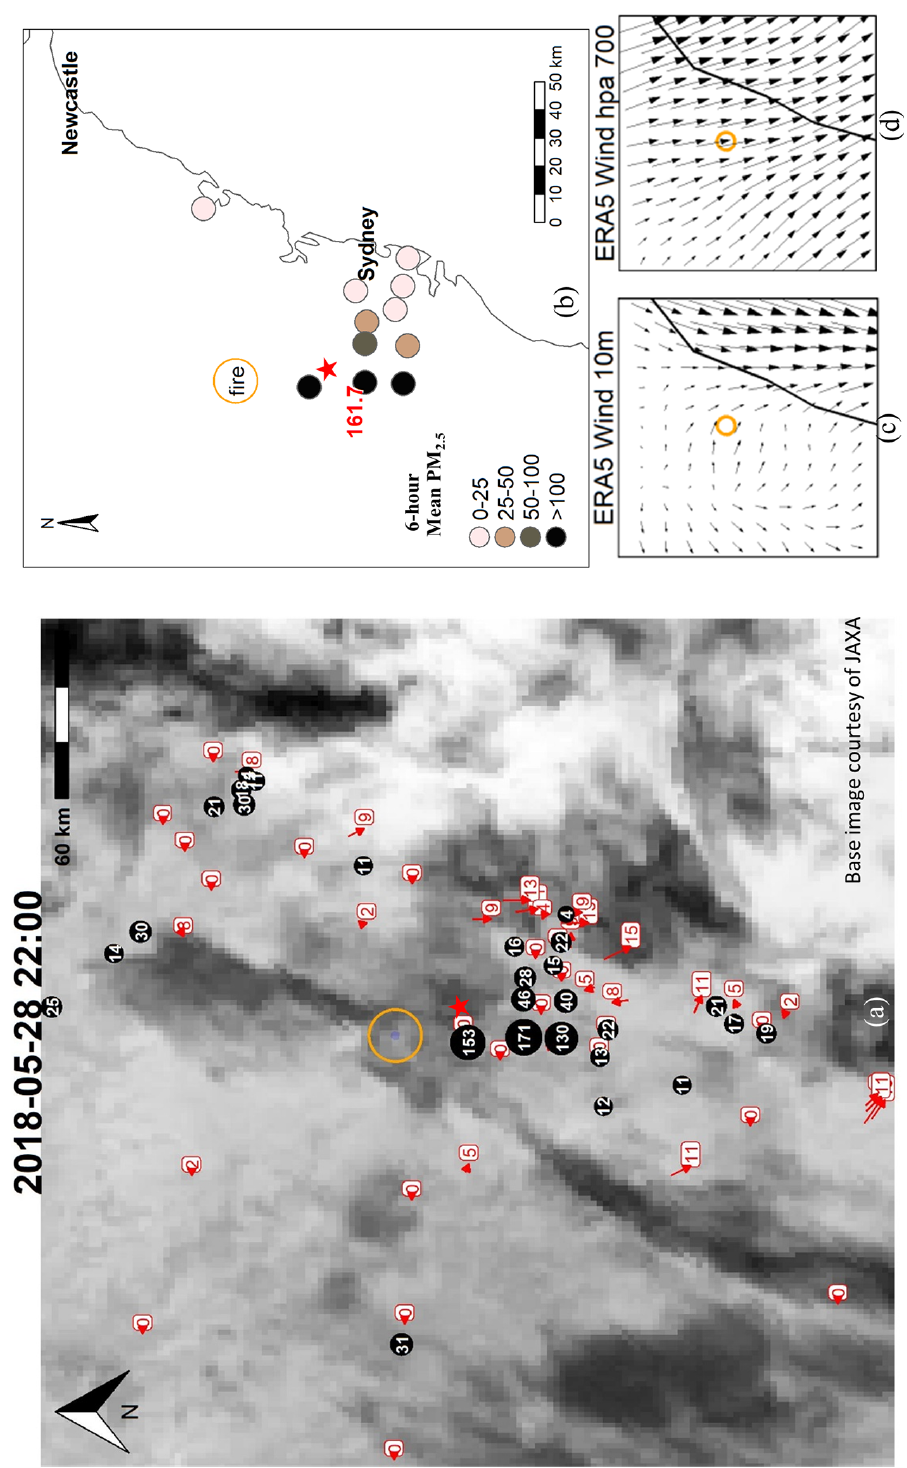
Figure A6. HRB night. The highest mean night HRB PM 2 . 5 was 161.7µgm − 3 at the second closest AQS in St Marys (red star), while the closest station was also high (Richmond = 129.4µgm − 3 ). This highest nighttime PM 2 . 5 for HRBs followed the highest afternoon PM 2 . 5 , i.e. the same day and fire (Fig. A5). The high afternoon PM 2 . 5 may have influenced the results this night as 10m winds were still low (c) , suggesting smoke may have lingered from the afternoon. Low wind speeds also meant that any new smoke produced during the night was probably not dispersed. The 10m winds (c) suggest smoke was not flowing directly from the fire to St Marys, as winds were westerly at the fire. However, the BOM winds (red arrows in a ) are zero at Richmond and St Marys at 22:00AEST, suggesting very calm conditions. Nat. Hazards Earth Syst. Sci., 22, 4039–4062, 2022